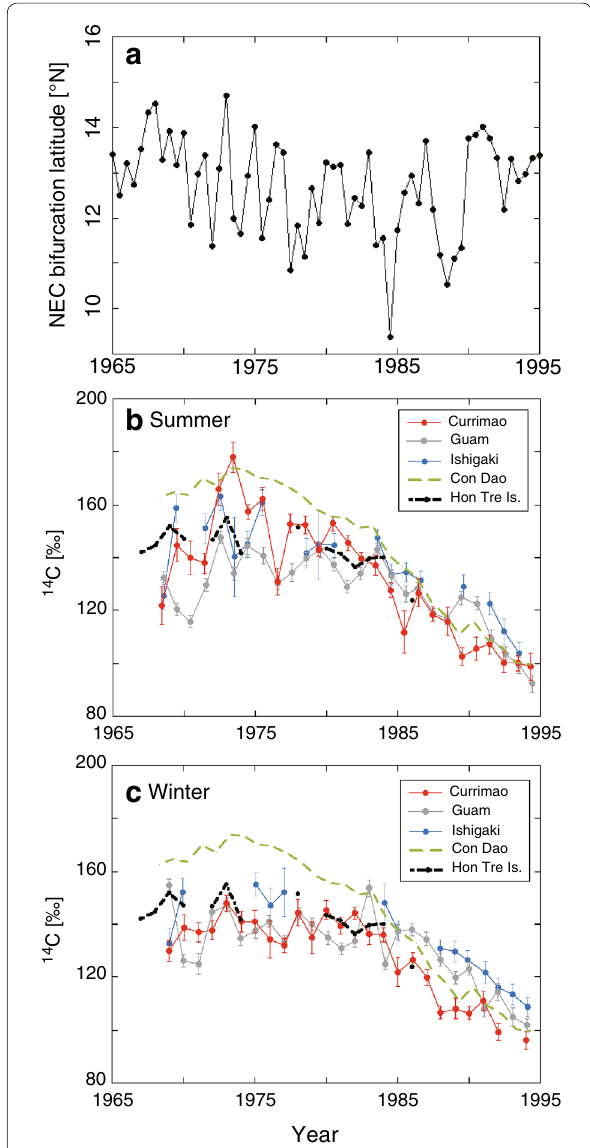
Fig. 4 a Seasonal average NEC bifurcation latitudes from 1965 to 1995 based on Zhao et al. (2013). Summer averaged latitude refers to the average latitude value of June and July. Winter averaged latitude refers to the average value of January and February. Δ 14 C in b sum‑ mer and c winter recorded in the corals sampled from Currimao (this study), Guam (Andrews et al. 2016), and Ishigaki (Hirabayashi et al. 2017a). Δ 14 C in Con Dao (Mitsuguchi et al. 2007) and Hon Tre